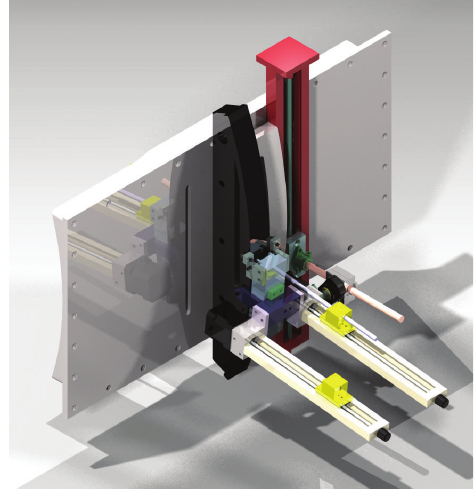
Figure 6: Probe traverser attached to the AFTRF instrumentation window, isometric